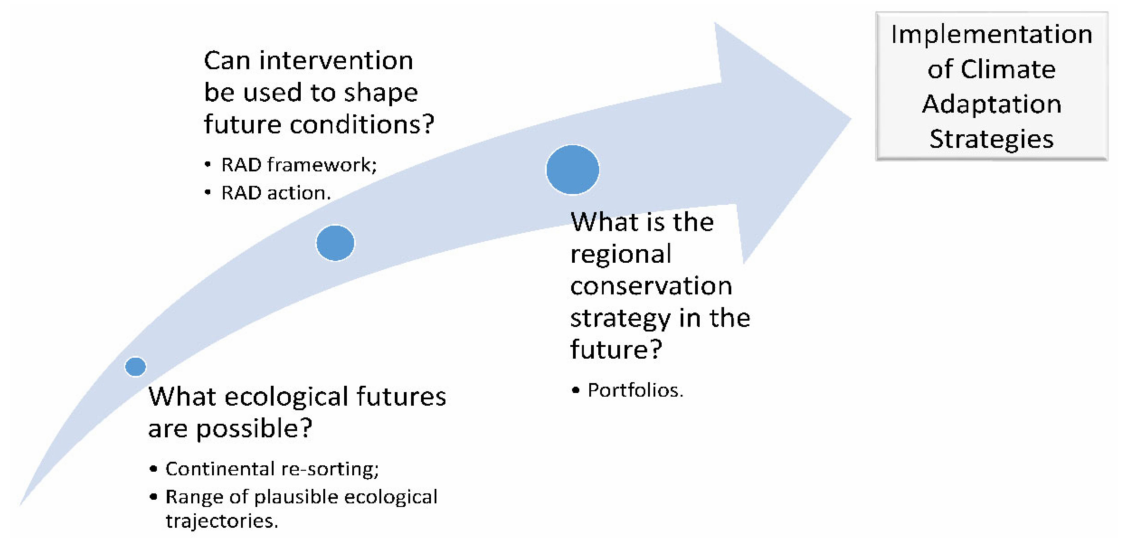
Figure 1. The blueprint identifies key questions that can help land management agencies craft and implement climate adaptation strategies that focus on stewarding biodiversity through future climate change. Each question is informed by management considerations